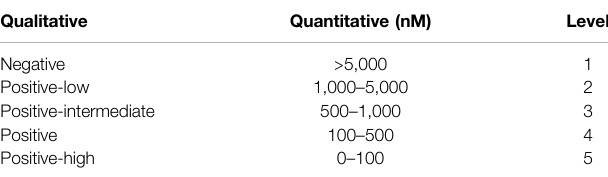
TABLE 1 | Binding af fi nity measurement